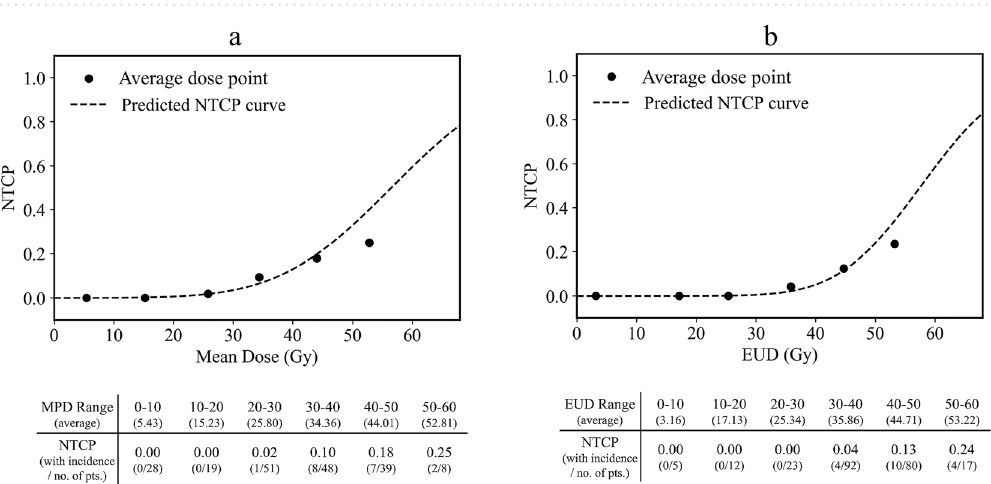
Figure 2. NTCP curves for A-PCE calculated by the MHD-based model ( a and c ) and LKB model ( b ). The x-axis indicates the MHD, which corresponds to the mean dose in the MHD-based model. Filled circles indicate average dose points for gEUD at 10 Gy intervals. NTCP curve by the MHD-based model also showed preferable fitting by linear regression ( c ). A-PCE, pericardial effusion in any grade; LKB model, Lyman–Kutcher–Burman model; MHD, mean heart dose; NTCP, normal tissue complicated probability; No. of Pts, number of patients; gEUD, generalised equivalent uniform dose.